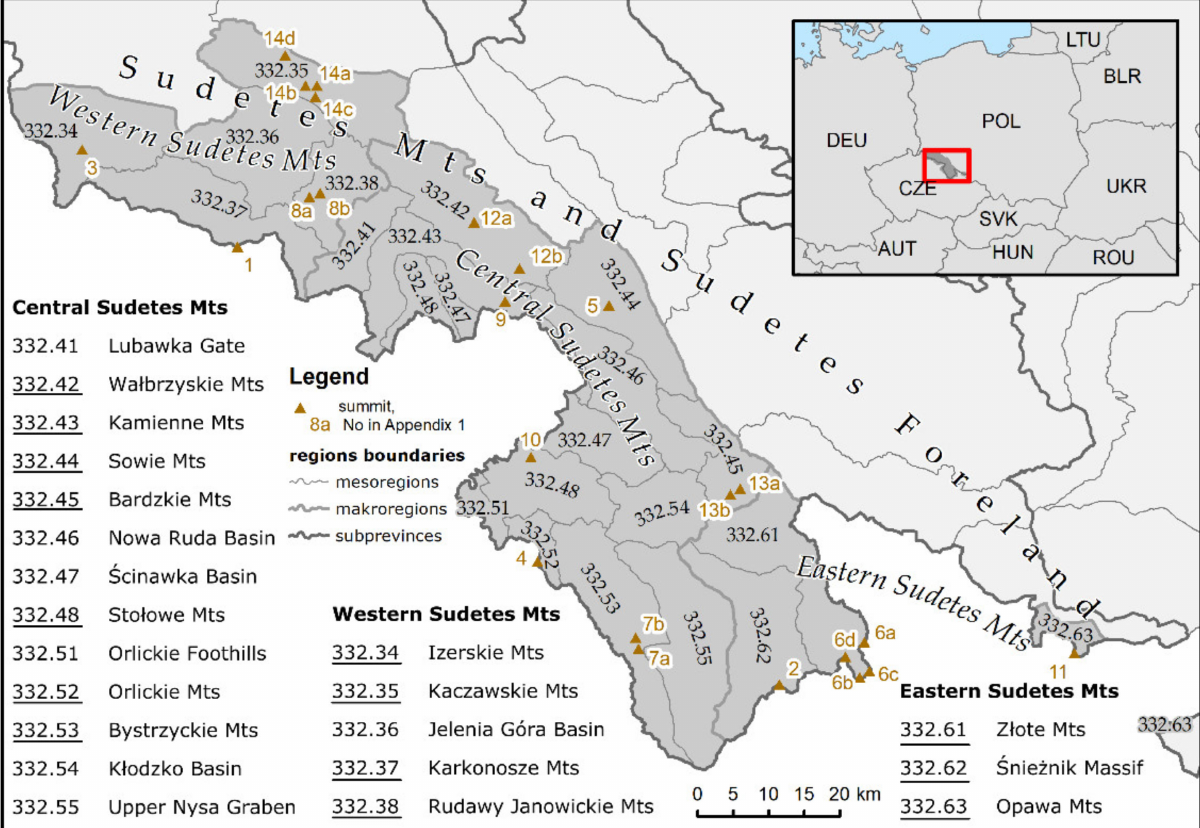
Figure 2. Study area. The codes of the mesoregions in which the measurements were taken are underlined. Sources: region boundaries [58], map of central Europe: © EuroGeographics, other: own